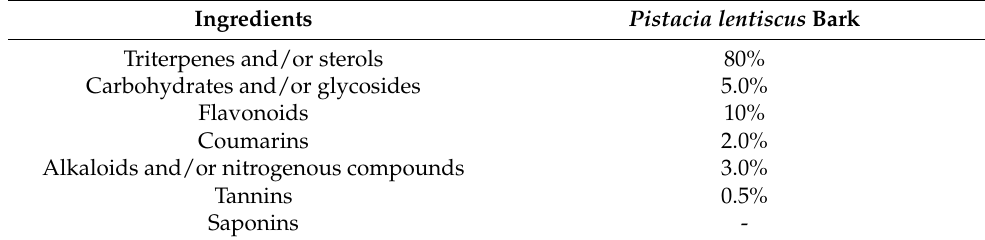
Table 1. Phytochemical analysis of the methanolic extract of Pistacia lentiscus bark. Ingredients